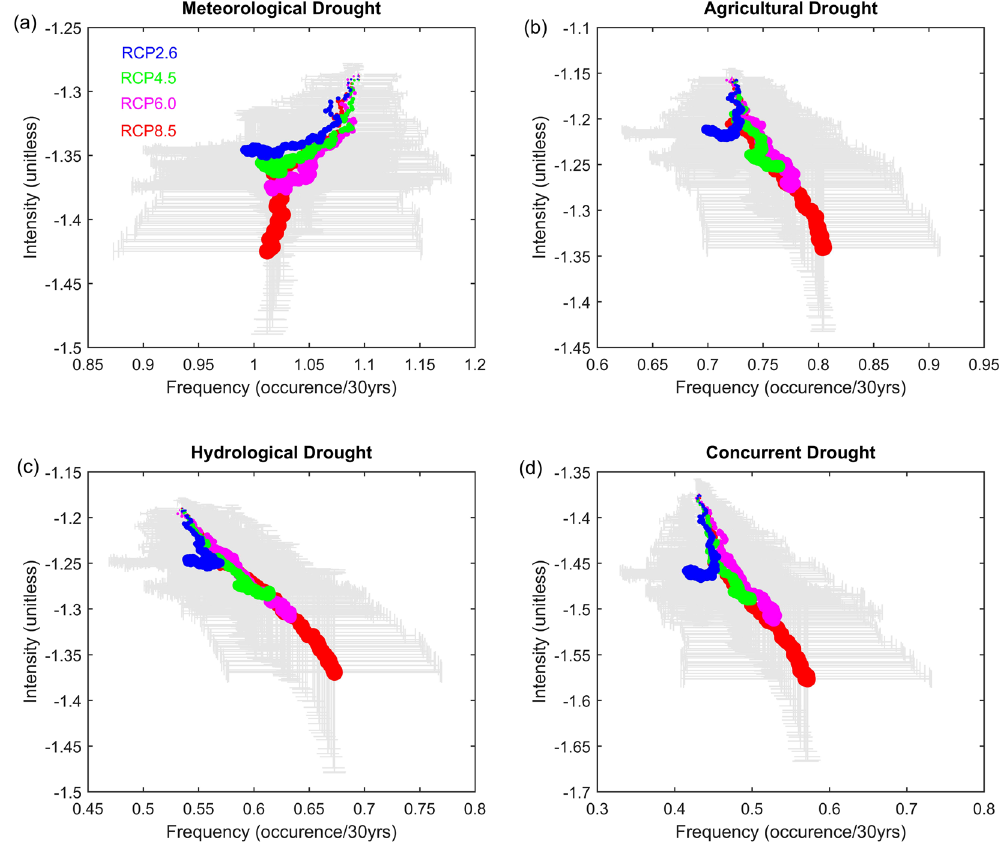
Figure 4. Same as Fig. 3 but for relations between drought frequency and intensity. Figure was created using software MATLAB 2015a